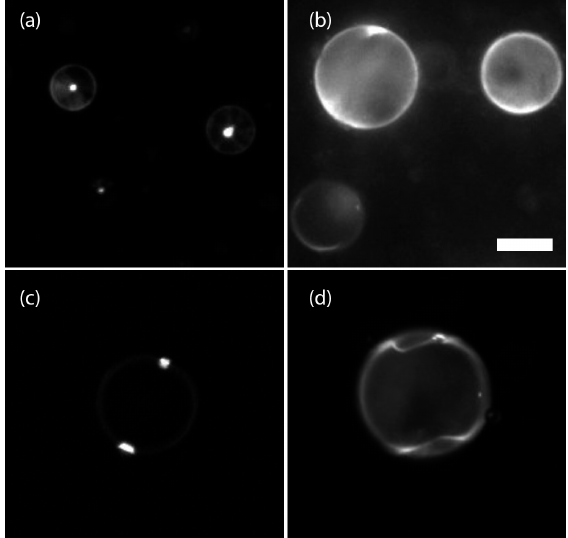
Figure 2 . Examples of quantum dot clusters formed via slow cooling of nematic droplets. ( a ) Clusters located at the center of a droplet, with the liquid crystal in a radial configuration. ( b , c ) Two different examples of quantum dot distributions in bipolar droplets at a low particle concentration and ( d ) at a higher particle concentration (For all images, bar = 20 μ m)